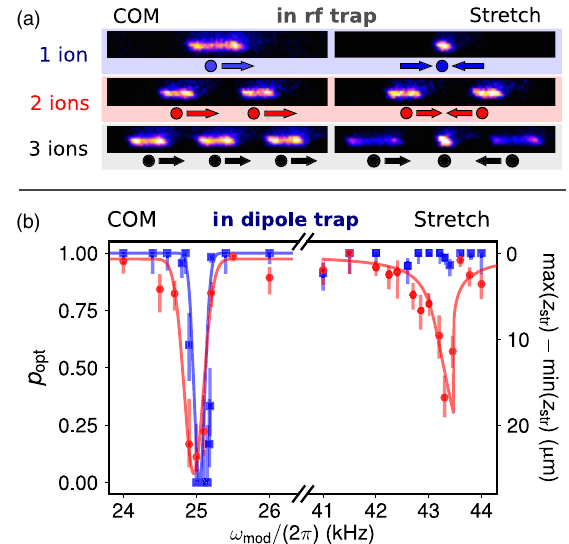
FIG. 4. Spectrometry of normal modes, demonstrating access to the axial phonons of the crystal during optical trapping. In (a), we show typical fluorescence images of ions in the rf trap with dc axial confinement, resonantly modulated with oscillating electric fields (the two-ion distance is 43 μ m, with other images to scale). ¼ 1 , we observe a single resonance for the axial motion For N ini ¼ 2 , 3, an additional resonance at ω str ¼ . For N at ω COM ffiffiffi p ax ax ini 3 ω COM , corresponding to out-of-phase motion, appears. (b) Op- ax ¼ 1 (blue squares) and N ¼ 2 tical trapping probability for N ini ini (red circles) ion(s) in the NIR trap, as a function of the frequency ω = 2 π of the oscillating electric field. We observe a drop in mod ¼ 1 and N ¼ 2 , in agreement with p at ω COM for both N ax opt ini ini the expected axial confinement. For the COM mode, the solid ¼ 2 π × ð 43 . 3 (cid:2) lines show fits to the data. The resonance at ω str ffiffiffi p ax 0 . 15 Þ kHz ≈ 3 ω COM (binned data points weighted with their ax statistical significance; for details on uncertainty, see text) only ¼ 2 and shows access to the motional emerges in the case N ini degrees of freedom of the Coulomb crystal during Δ t . In the opt case of the stretch mode, we modulate the harmonic confinement to excite differential motion between the ions. The electric field amplitude at the equilibrium positions of the ions amounts to j E j ¼ ð 1 . 8 (cid:2) 0 . 1 Þ mV = m, for which we numerically simulate the out-of-phase motion (no free parameters). We depict the ampli- ð t Þ(cid:3) − min ½ z ð t Þ(cid:3) by the solid tude of the stretch mode by max ½ z str str red line (axis on the right-hand side). The nonlinearity of the Coulomb interaction leads to an asymmetric frequency response (see Supplemental Material [30]). We emphasize that the ð t Þ(cid:3) − min ½ z ð t Þ(cid:3) is nontrivial dependence of p on max ½ z opt str str and not taken into account